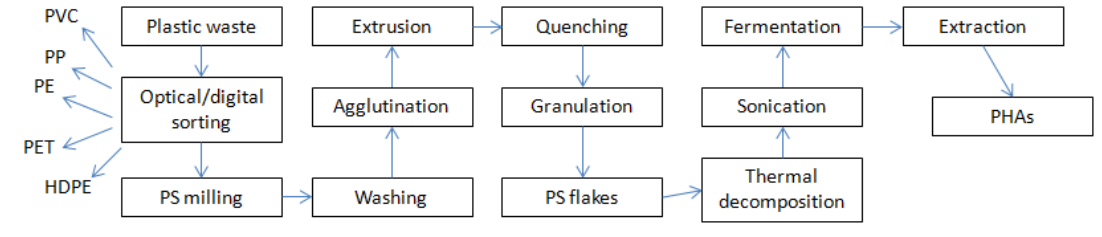
Figure 2. Proposed recycling stages, adapted from [22].